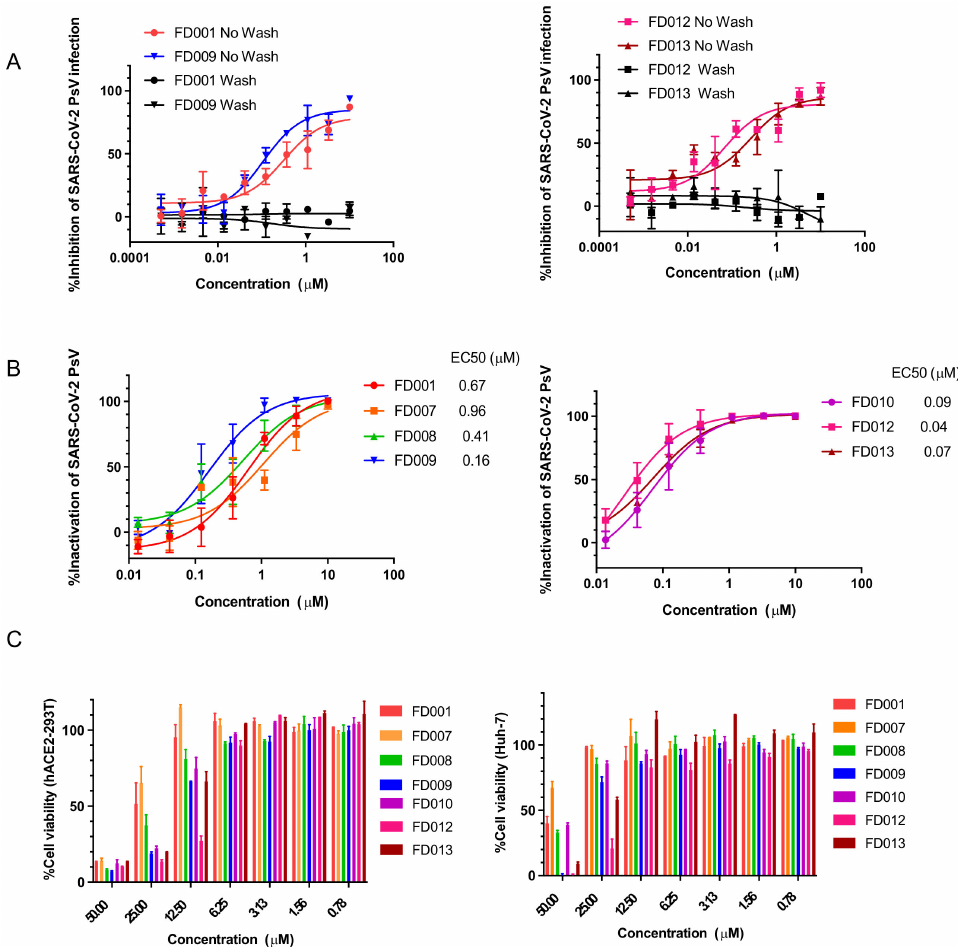
Figure 2. FD-compounds exerted antiviral activity by targeting cell-free virions, rather than the cells. ( A ) FD-compounds exhibited inhibitory activity against infection of SARS-CoV-2 PsV when they were preincubated with hACE2-293T cells at 4 ◦ C without washes, but no inhibitory activity after the compounds were washed out, before addition of PsV; ( B ) FD-compounds inactivated cell-free SARS-CoV-2 PsV; ( C ) cytotoxicity of FD-compounds on hACE2-293T and Huh-7 cells. Data are means ± SD of triplicate samples from a representative